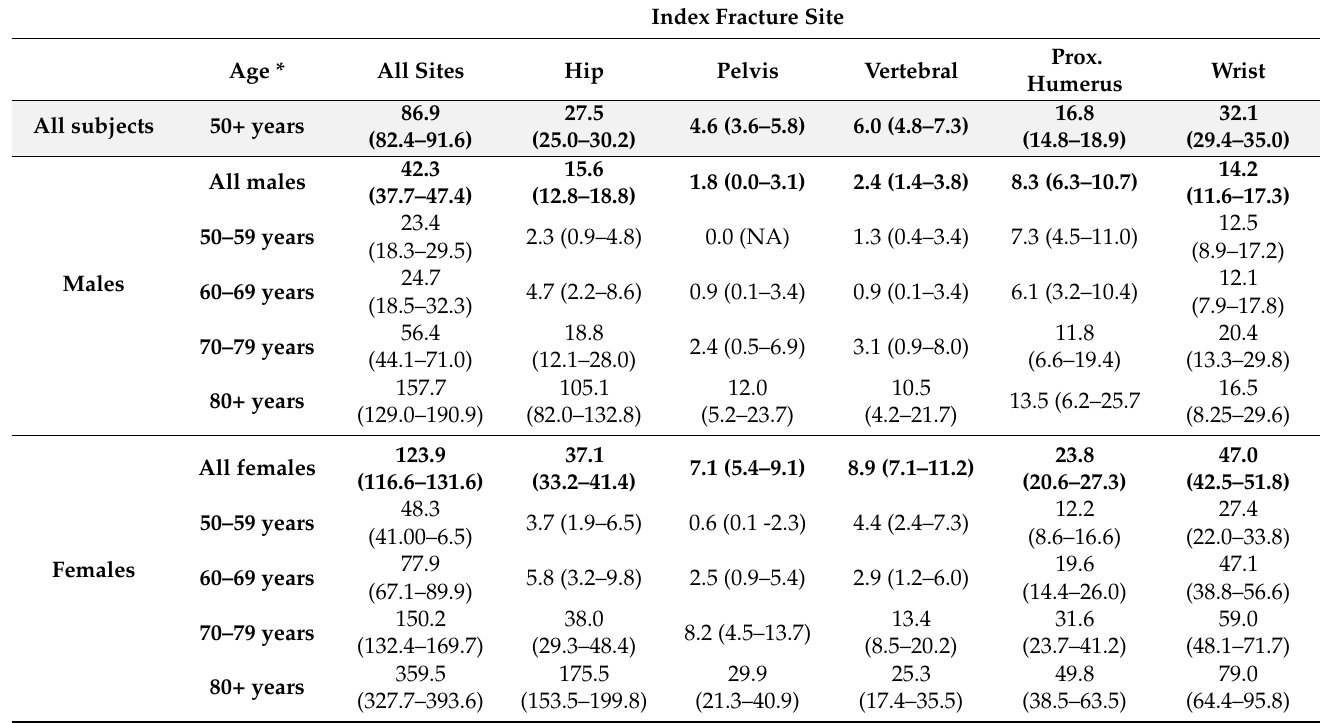
Table 1. Incidence rate of index fracture in the general population aged ≥ 50 years, by index fracture site, sex, and age group. The total population values for males and females are marked in bold. The shading indicates that they are total values of the population, to differentiate them from the rest that are separated by gender and